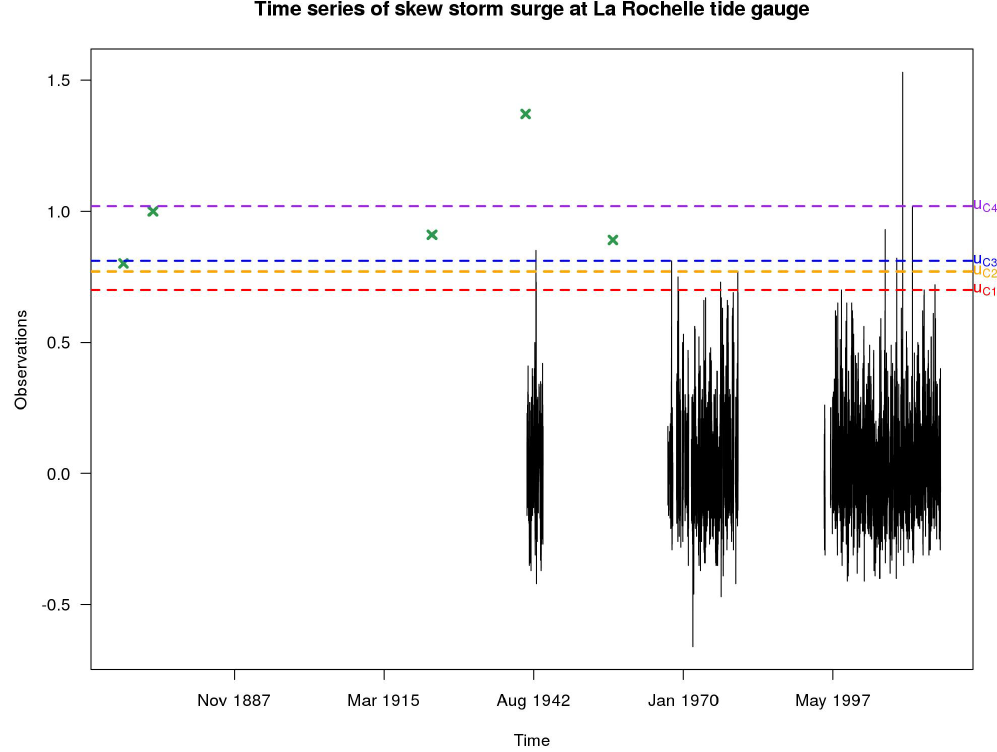
Figure 2. Skew surge dataset of Sect. 3 (composed of systematic and historical data) used in the computation of credible duration with 4 different thresholds u c 1 , u c 2 , u c 3 , u c 4 . The four sampling thresholds u c are used linked to a rising value o λ ( λ c 1 = 0.5, λ c 2 = 0.23, λ c 3 = 0.2, λ c 4 =